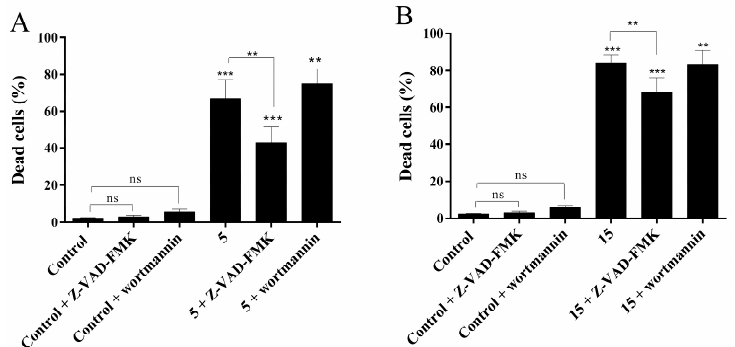
Figure 6. Cell death induced by compounds 5 and 15 involves the caspases pathway. MCF7 cells were pre-incubated with 50 μ M of Z-VAD-FMK or 100 nM wortmannin for 1 h before treating cells with compound 5 (25 μ M), compound 15 (30 μ M) or vehicle (control) for 48 h. Cells were stained with the Apo-Direct kit (TUNEL assay) and analyzed by flow cytometry. ( A ) Cell death induced by compound 5 in the presence and absence of the inhibitors; ( B ) Cell death induced by compound 15 in the presence and absence of the inhibitors. Results show the mean ± SEM of at least three independent experiments performed in duplicate, ** p < 0.01, *** p < 0.001.